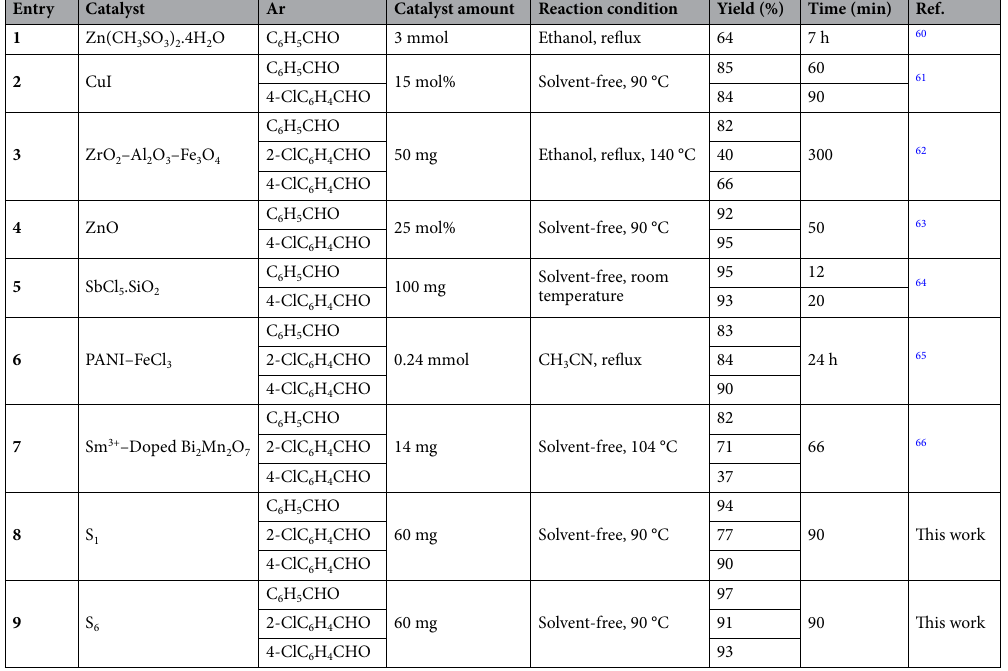
Table 8. Comparison of synthesized NiO nanocatalyst with other